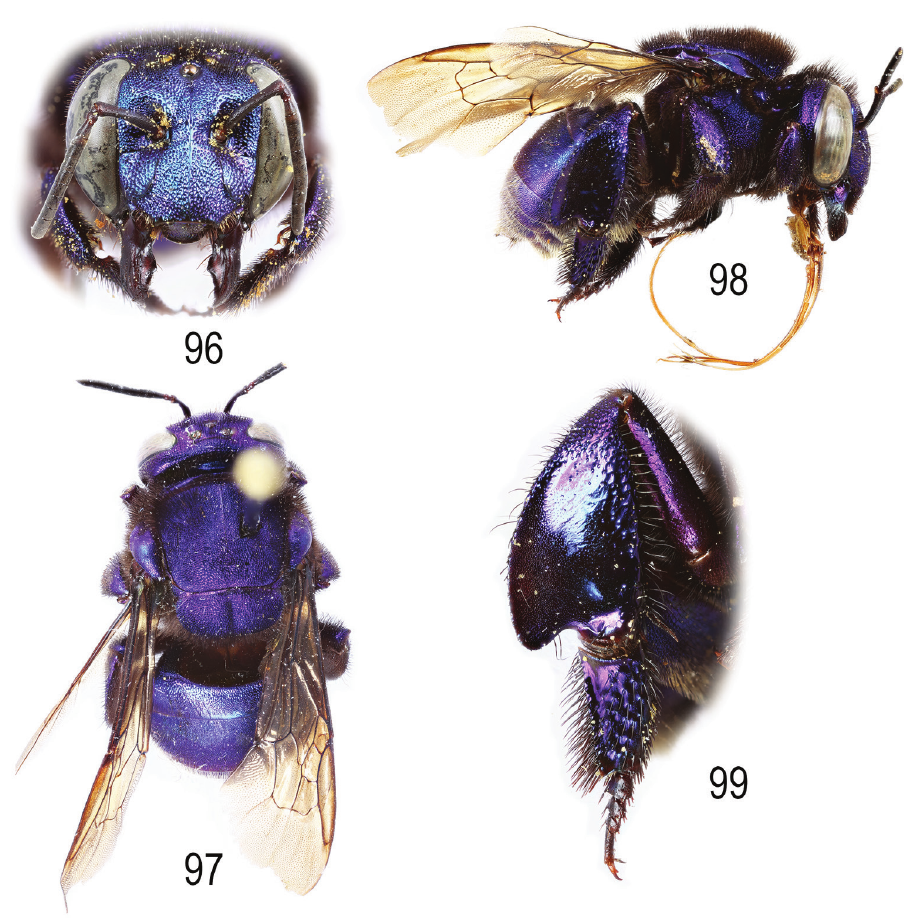
Figures 96–99. Female paratype of E. barthelli (Mexico: Morelos, Tepoztlán, UNAM 01827). 96 Facial view 97 Dorsal habitus 98 Lateral habitus 99 Outer view of hind